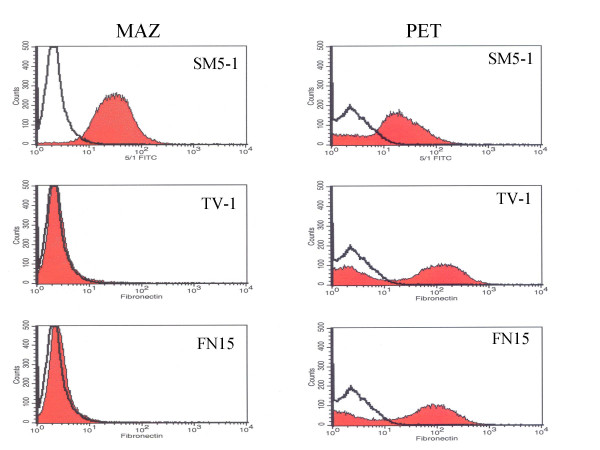
FACS analyses with SM5-1 and Fibronectin antibodies in MAZ and PET cell line. Human melanoma cell lines MAZ and PET react with mAb SM5-1. MAZ reacts also with fibronectin mAbs TV-15 and FN15 while PET does not.